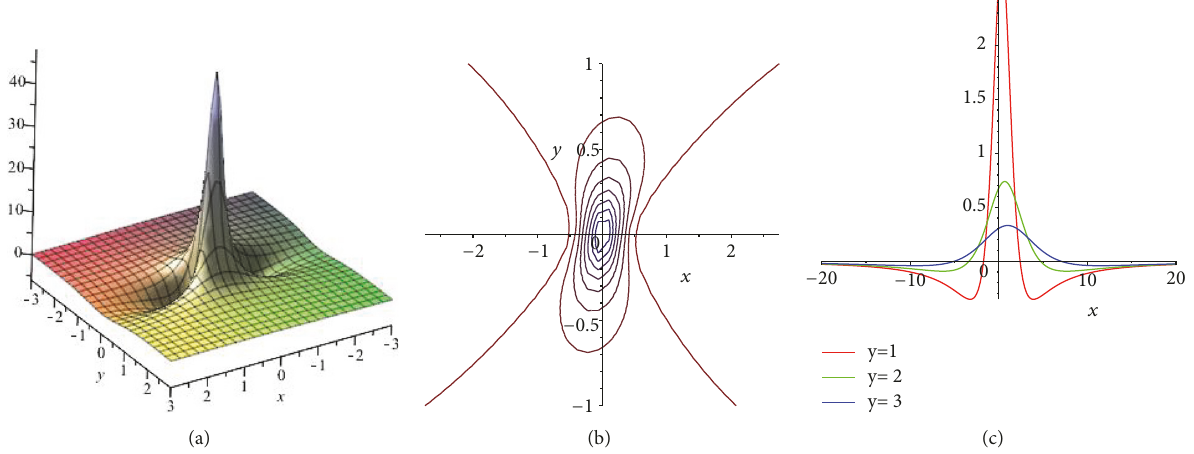
Figure 1: Plots of lump solution in Case 1 with 𝑎 2 = 4 , 𝑎 4 = 0 , 𝑎 5 = 2 , 𝑎 8 = 0 , 𝑎 9 = 1 at 𝑡 = 0 : (a) 3D plot, (b) density plot, and (c) x-curves.